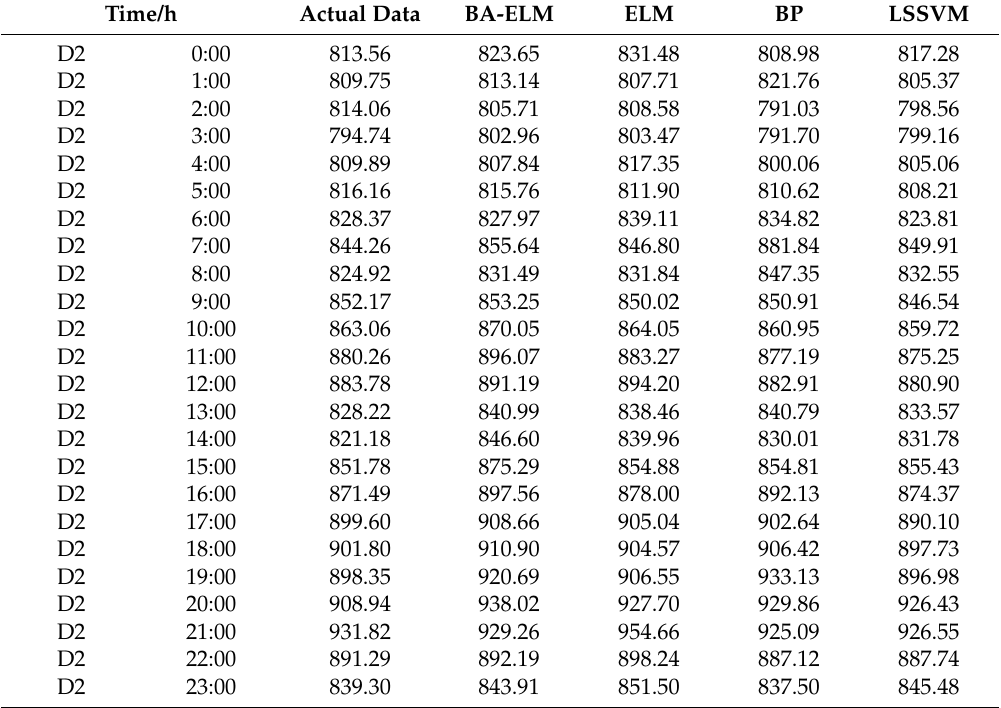
Table 8. Actual load and forecasting results on Day 2 (Unit: MV).